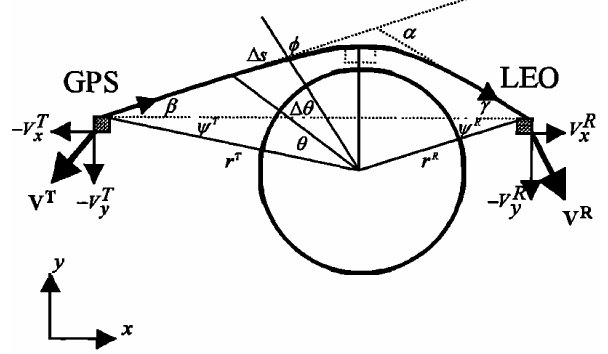
Figure 1. Radio occultation geometry. Reproduced from Healy